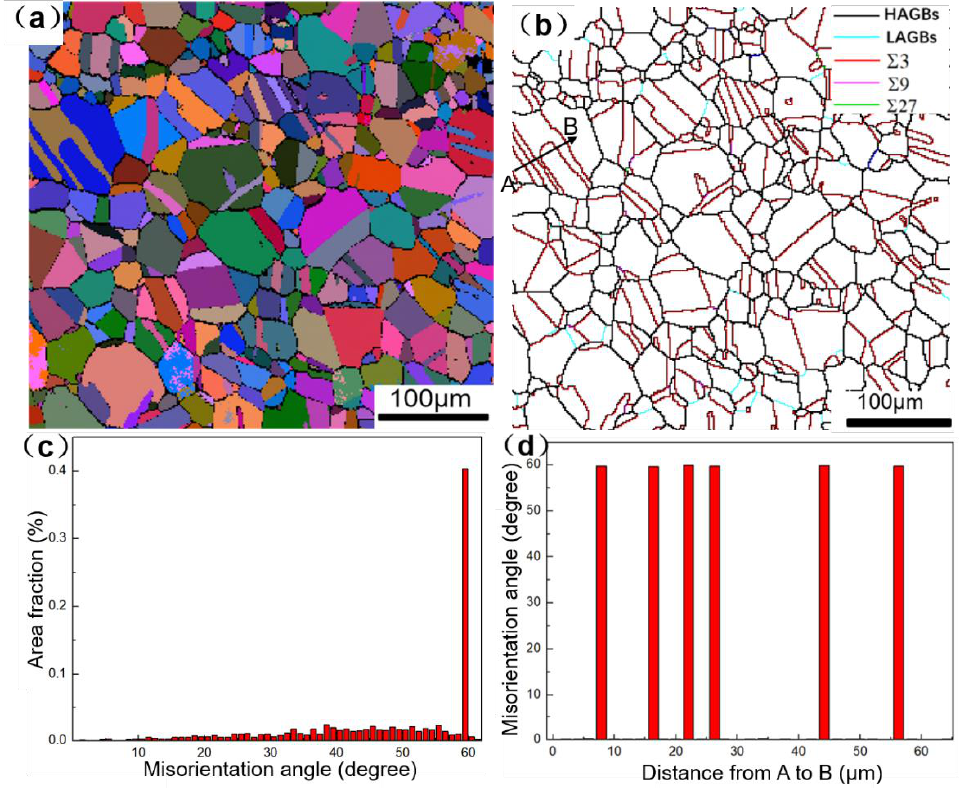
Figure 1. The microstructure of the GH3625 with as-received status: ( a ) all Euler diagrams; ( b ) OIM map; ( c ) misorientation angle distribution map; ( d ) misorientation angle from A to B.